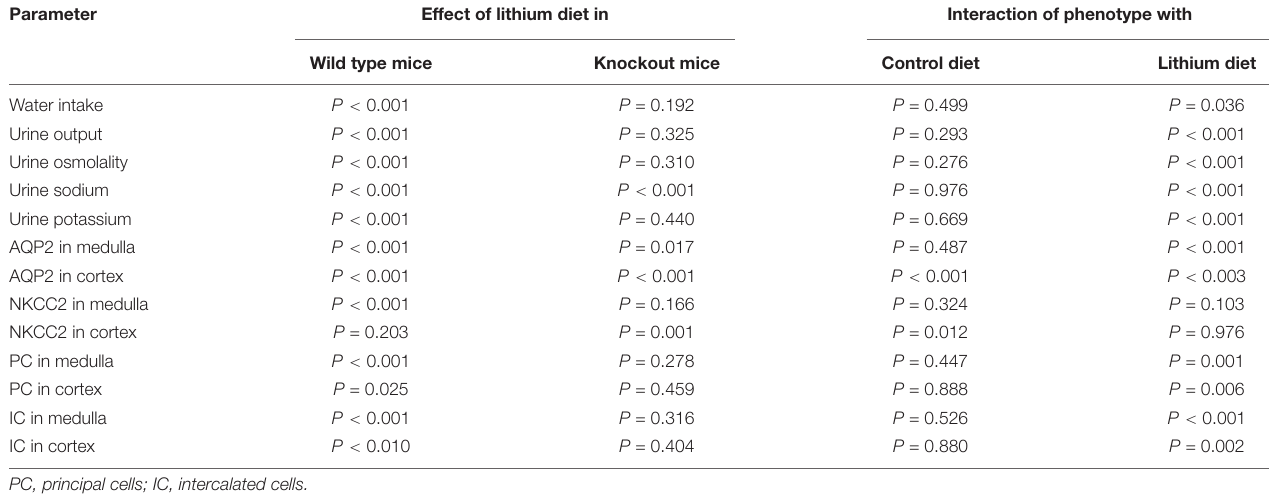
TABLE 1 | P -values for the two-way analysis of variance of the data. Parameter Effect of lithium diet in Interaction of phenotype